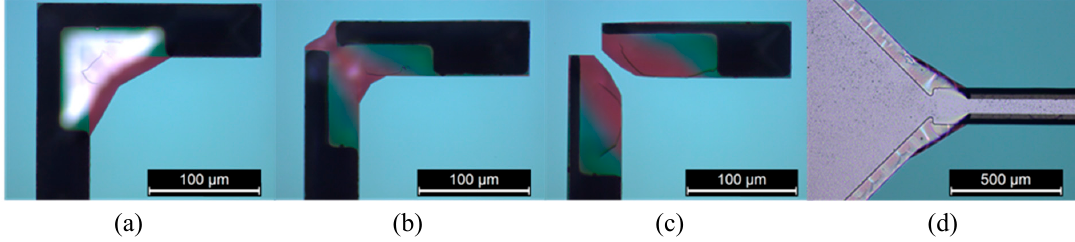
Figure 8. Optical microscopy image of the intersections of channels obtained using several sets of compensation structures, depth etch = 77 μ m ( a ) case of set Q1; ( b ) case of set Q2; ( c ) case of set Q3; ( d ) case of set I1.